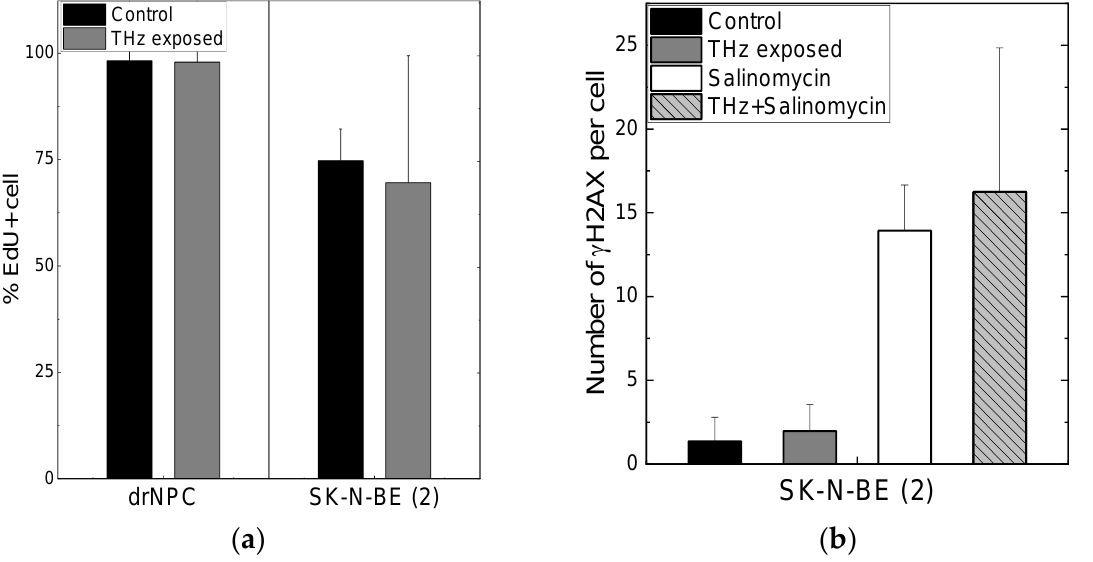
Figure 4. Proliferative activity of neuronal cells and formation of the foci of histone H2AX phos- phorylation: ( a ) The number of cells in the synthesis phase of the cell cycle, detected through the EdU incorporated in cell DNA; ( b ) the number of γ H2AX per cell in the human neuroblastoma line (SK-N-BE(2)).